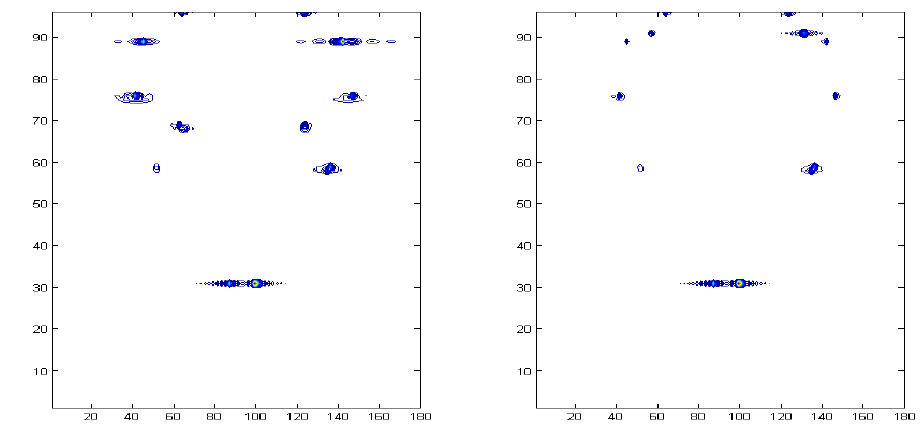
Fig. 9. Comparative images for two-channel radar with pulse radiation, only the 10 brightest reflectors are modelled.